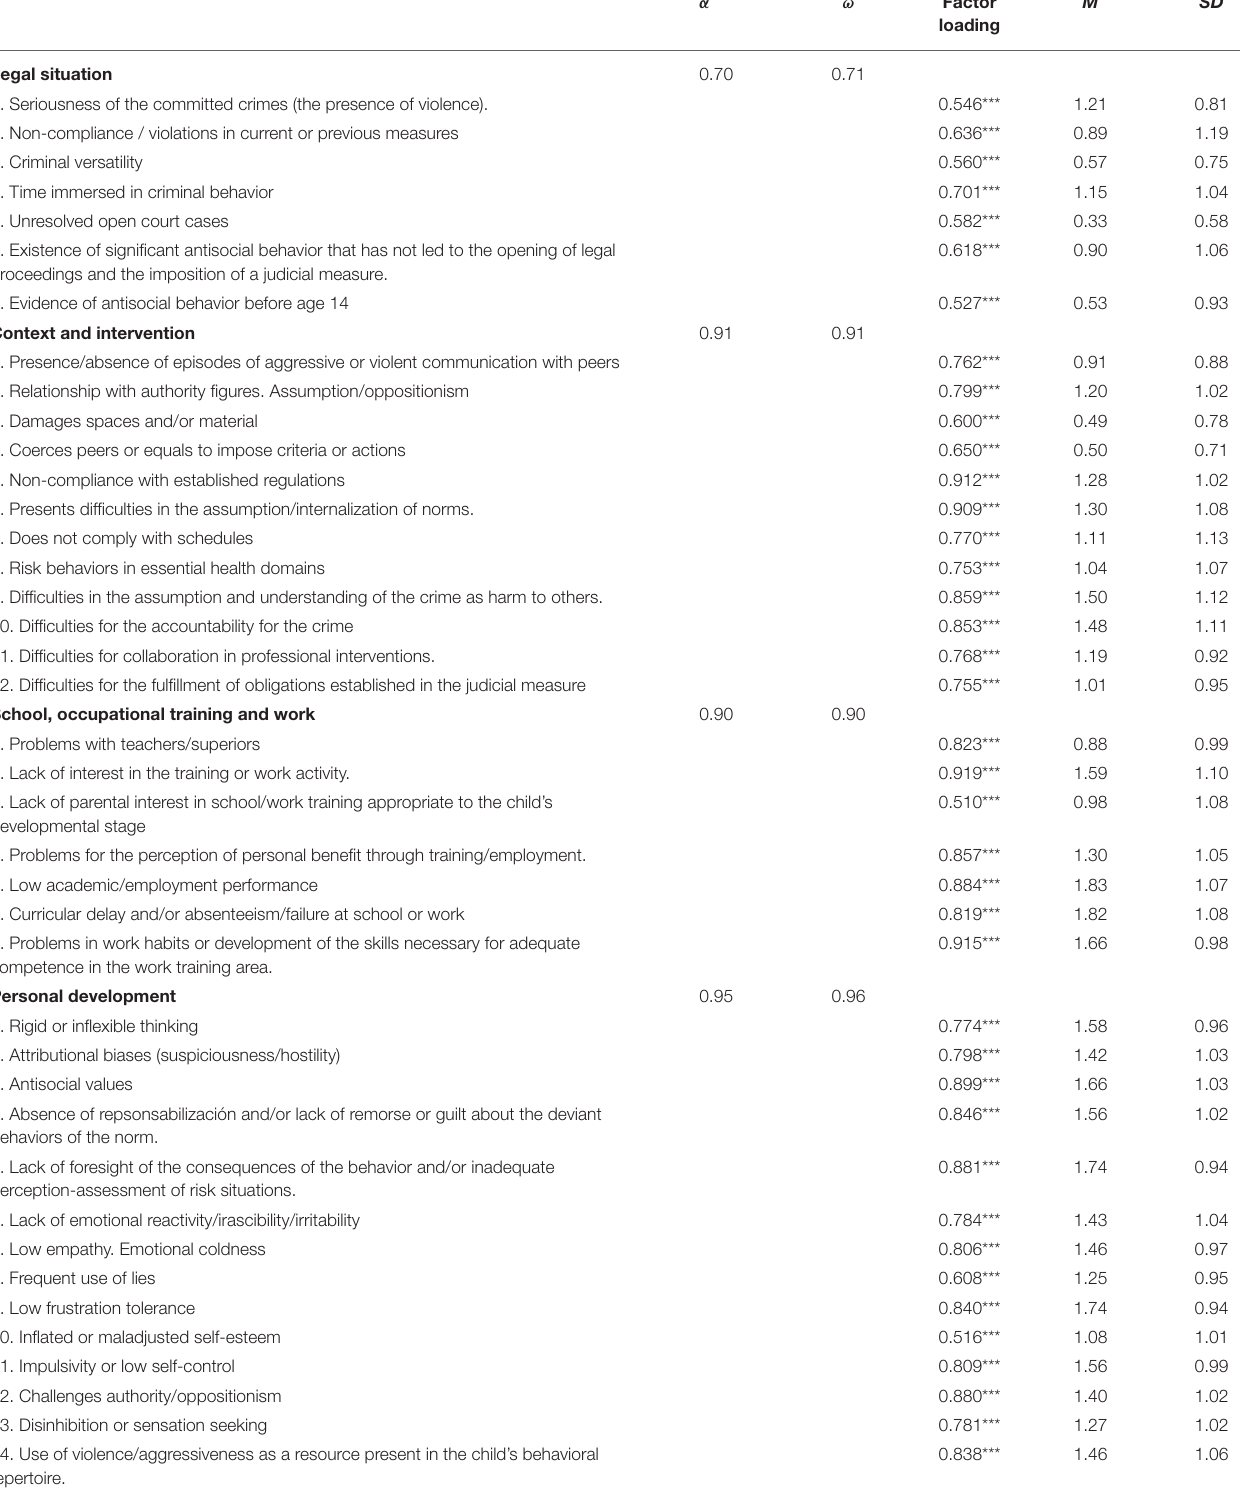
TABLE 2 | Scale Items and Psychometric Properties for PREVI-A dimensions